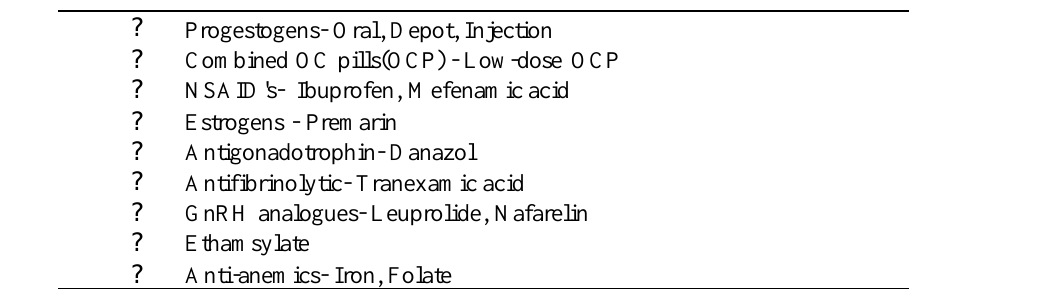
Table VI : Drugs commonly used in treatment of DUB (Adapted from Dangal G 6 )